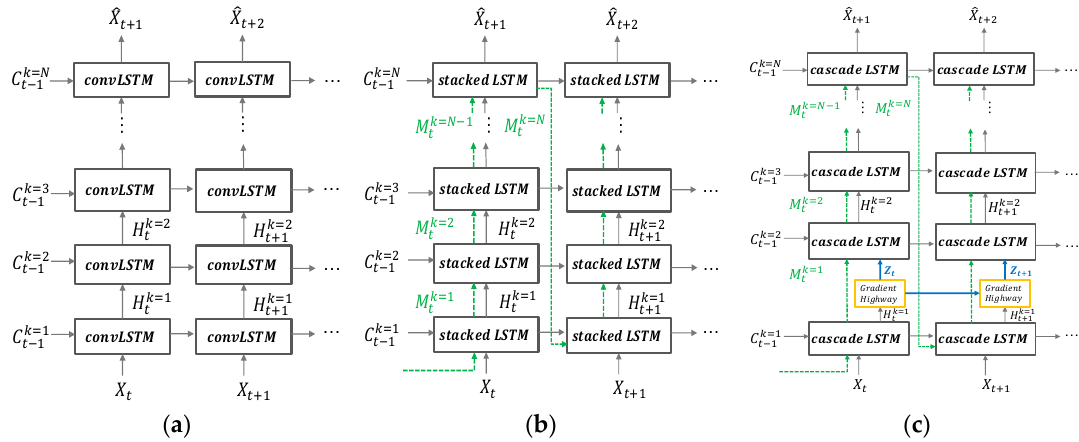
Figure 6. Structural differences of ( a ) convolutional stacking LSTM; ( b ) PredRNN; ( c ) PredRNN++. PredRNN and PredRNN++ have in common that they use a spatiotemporal memory transient concept, but PredRNN++ differs from PredRNN in that it has unique structures of increasing recurrent depth. PredRNN++ has a cascade spatiotemporal memory that is effective in analyzing spatial correlation. Its cascade LSTM unit has a dual memory form of temporal memory and spatial memory. The spatial memory, 𝑀 (cid:3047)(cid:3038) , depends on 𝑀 (cid:3047)(cid:2879)(cid:2869)(cid:3038) from the transient path, which is represented by dotted lines in Figure 6c. The temporal memory 𝐶 (cid:3047)(cid:3038) depends on previous state 𝐶 (cid:3047)(cid:2879)(cid:2869)(cid:3038) and is adjusted by current forget, input and input modulation gate. Here, 𝑘 indicates the vertical depth of the layer. Another difference is the existence of the gradient highway unit (GHU), which prevents quick vanishing and can send the gradient information to the deeper layer. The advantages of GHU were confirmed through various experiments [41].